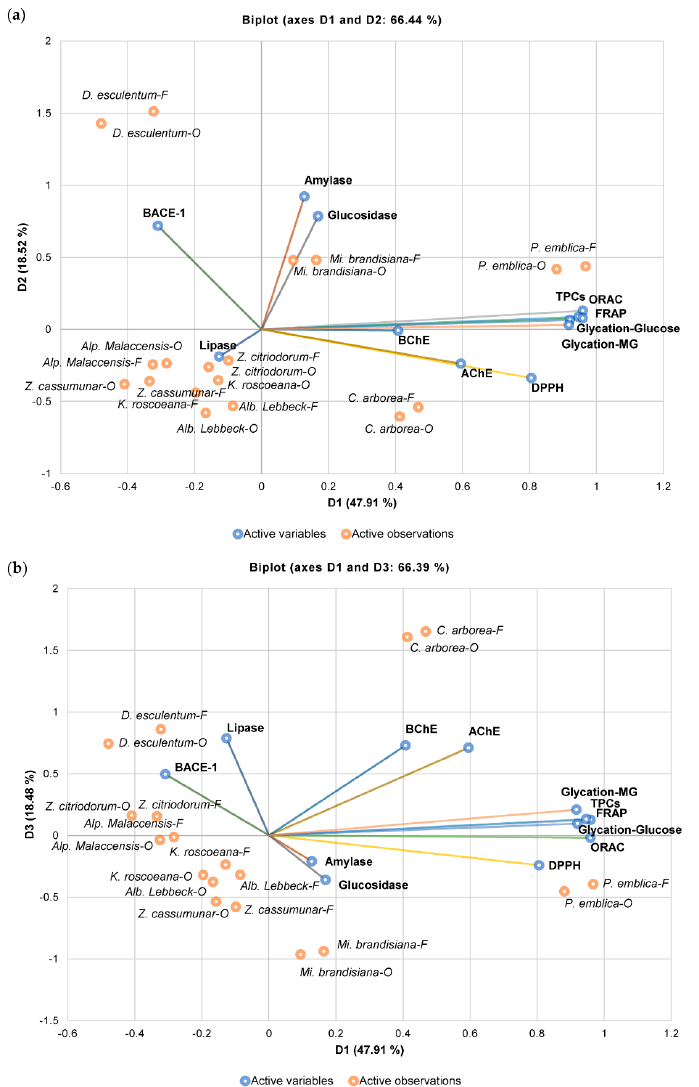
Figure 2. Principal component analysis (PCA) from mean values of tested variables including TPCs, antioxidant activities (determined by 2,2-diphenyl-1-picrylhydrazyl (DPPH) radical-scavenging, ferric reducing antioxidant power (FRAP), and oxygen radical antioxidant capacity (ORAC) assays), enzyme-inhibitory activities (against α -amylase, α -glucosidase, lipase, acetylcholinesterase (AChE), butyrylcholinesterase (BChE), and β -secretase (BACE-1)), and anti-glycation activities (methylglyoxal (MG) and sugar induction) of observations (freeze-dried and oven-dried plant extracts): ( a ) biplot between PC1 and PC2; ( b ) biplot between PC1 and PC3.